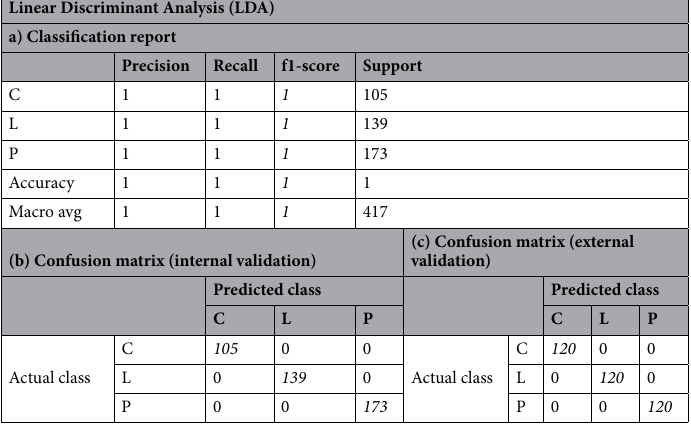
Linear Discriminant Analysis